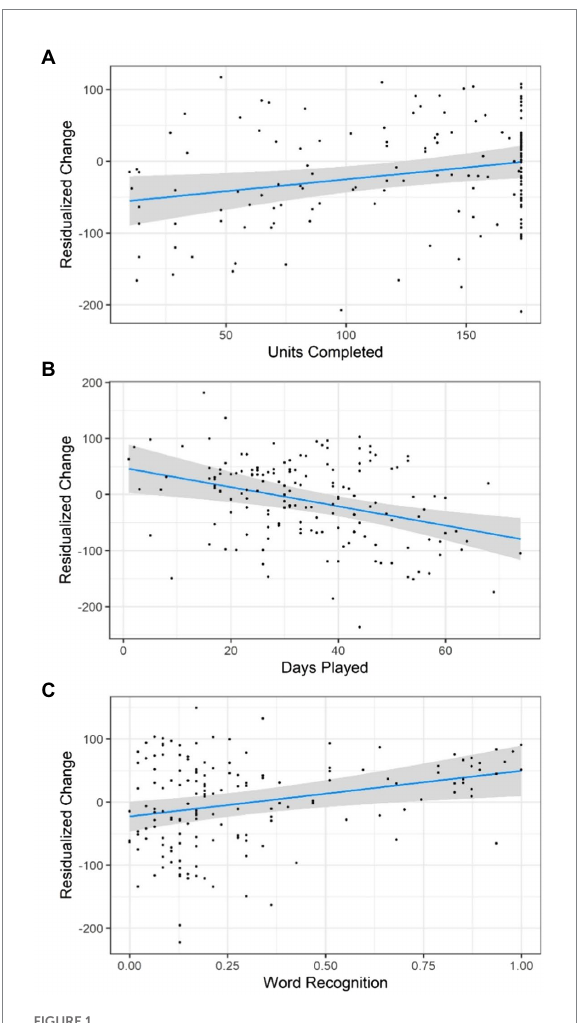
FIGURE 1 Significant predictors of STAR early literacy score difference. The effect of number of units completed (A) , number of days played (B) , and word recognition skill at the beginning of the GraphoLearn program (C) on residualized STAR Early Literacy change scores. The plots present conditional effects, controlling for all predictors included in the model in Table 3. Older kids had greater residualized gains on average when controlling for other factors. Plots created using the visreg R package (Breheny and Burchett,